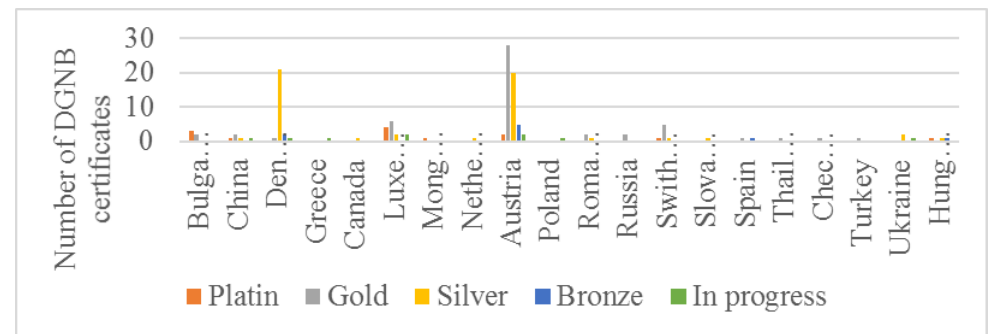
Fig. 2. DGNB Certification in the World (DGNB System, 2016b) [Figure made by